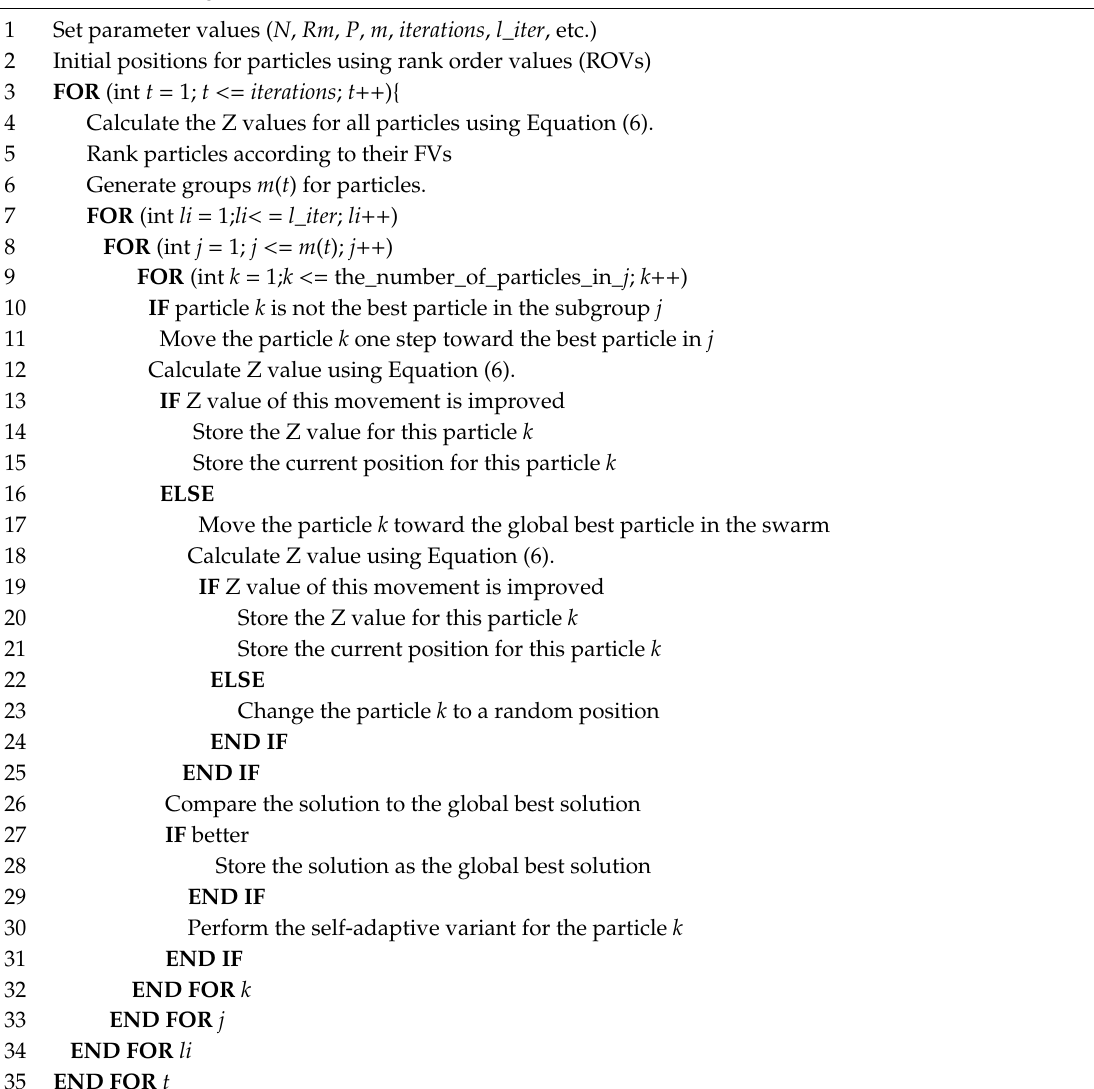
Algorithm 1. The logic flow of